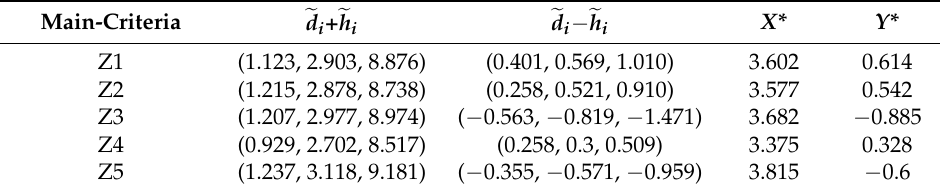
Table 11. The values of vector d + h , d − h , X* and Y* for the main criteria.